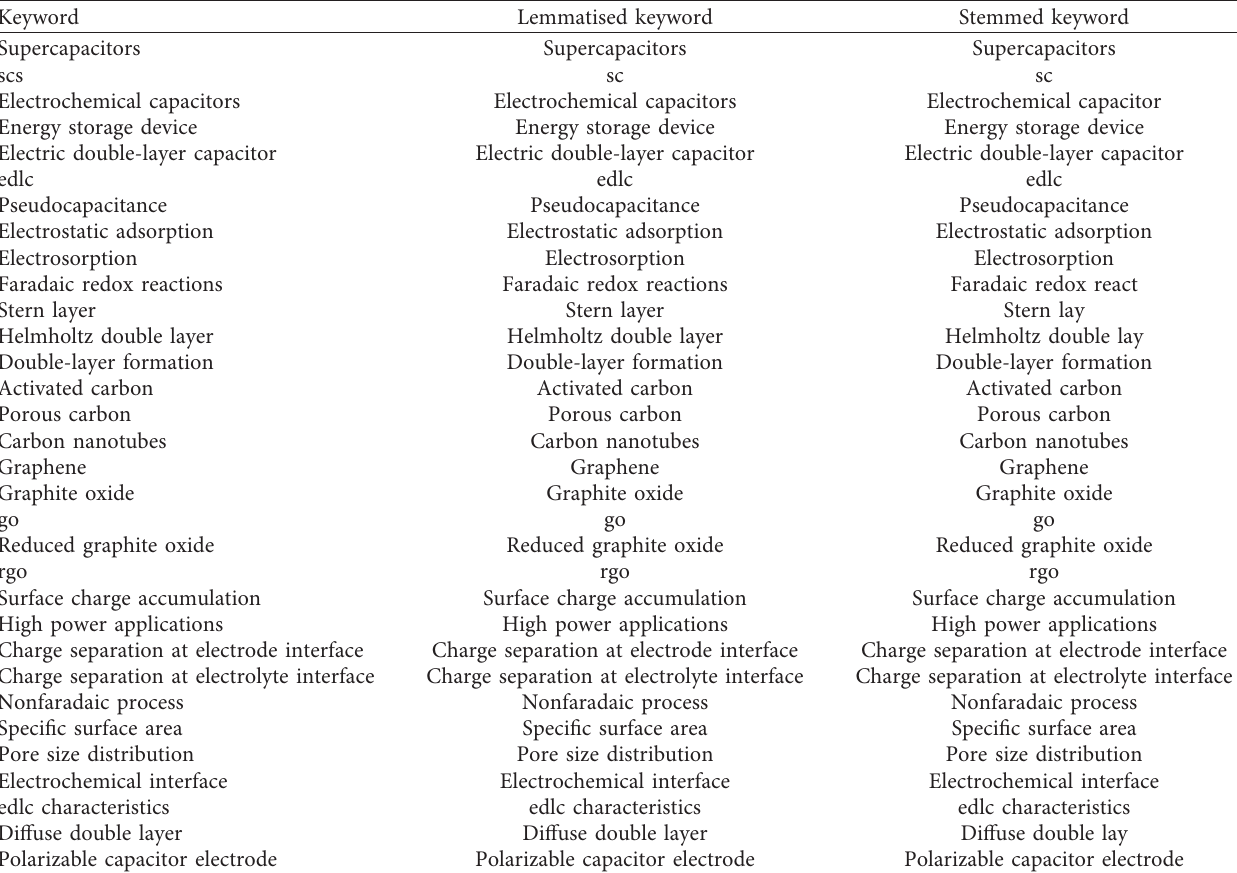
Table 1: Domain expert-curated keywords for EDLC domain with lemmatised and stemmed version. From left, keywords’ column contains the original keywords provided by the domain experts. Lemmatised keyword and stemmed keyword columns contain lemmatised and